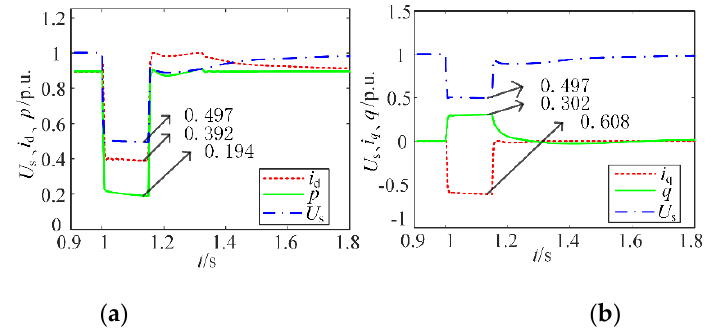
Figure 7. Simulation results in case (1) of the fault on location A: ( a ) active output of PV generator; ( b ) reactive output of PV generator.